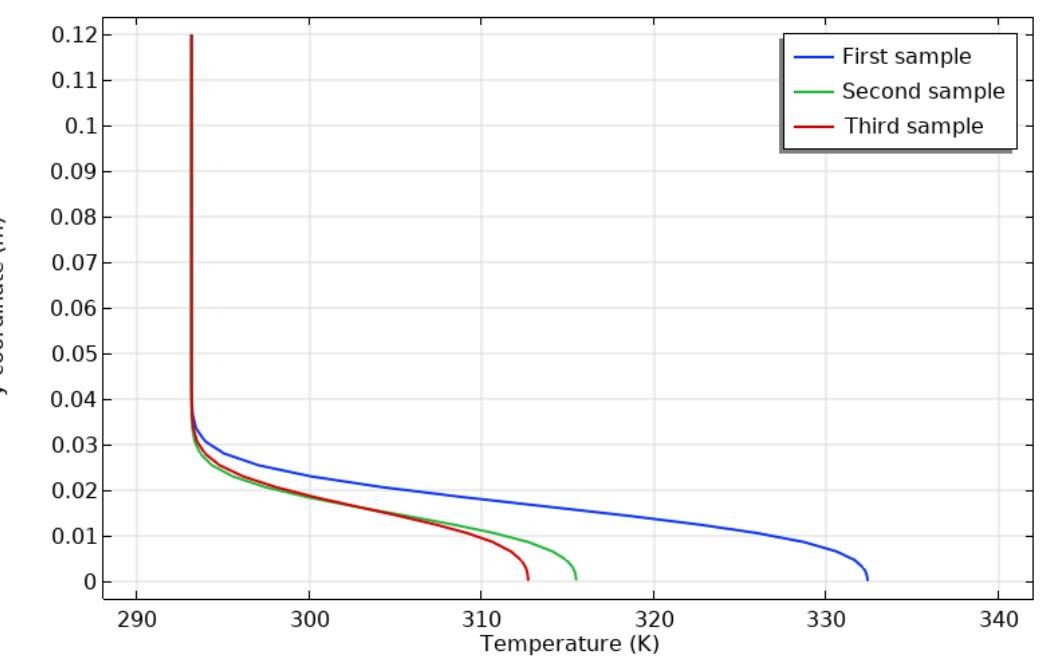
Figure 19. Temperature profile in the outlet passage flow. The air density profile in the outlet channel passage flow at a constant input flow Reynolds number of 2.8814 (0.1 m/s) and a constant heat source power of 20 W located at different locations in the enclosure is shown in Figure 20. Because moving away from the source of heat causes an increase in the y directions, an increase in the y value causes an increase in the air density. At y = 0.035 m, the air density profile begins to differ from one case to other, the third case has the largest value than the second, and the latter has the largest value in density distribution than the first case.